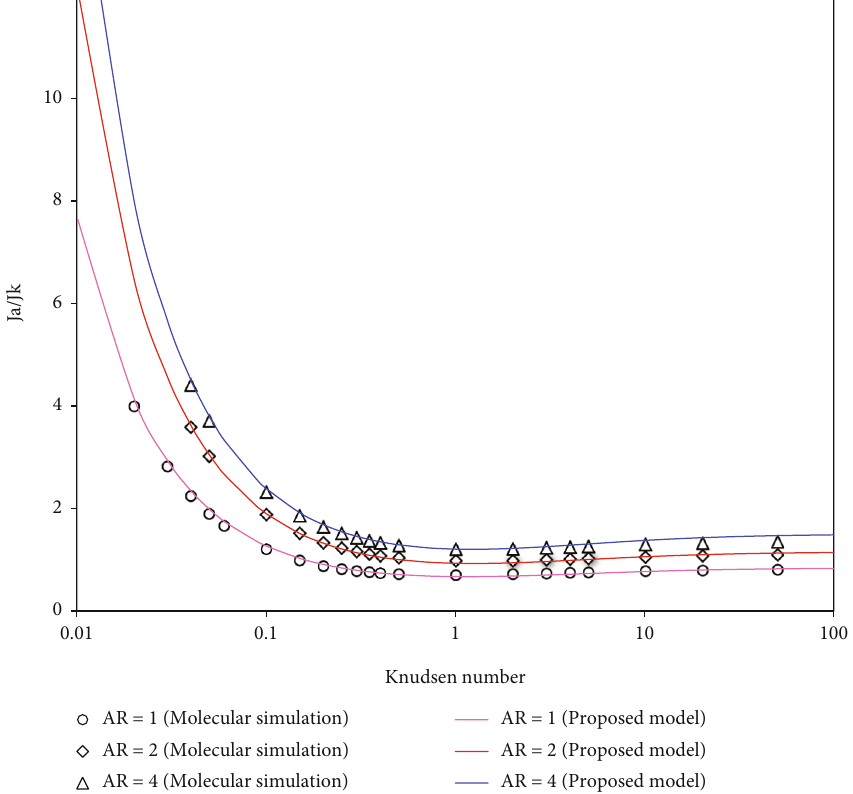
Figure 4: Comparison between proposed model and molecular simulation with high Kn